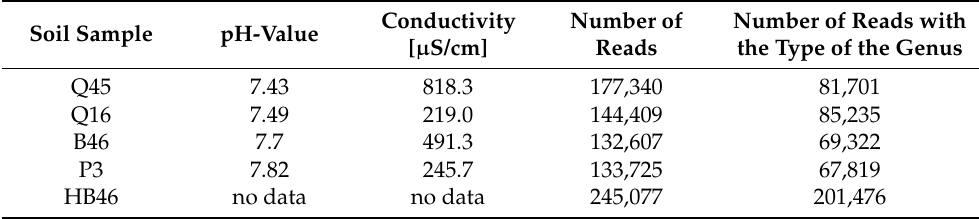
Table 3. Characteristics of soil